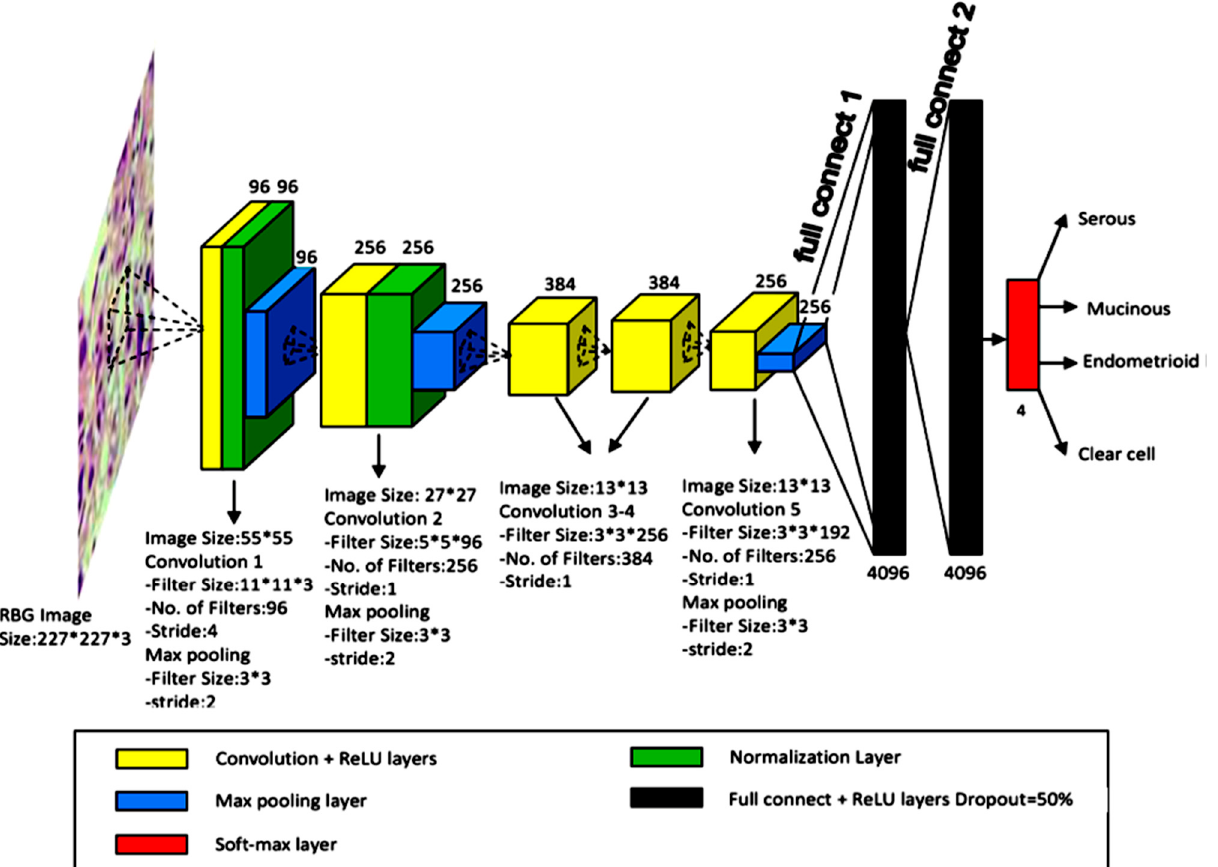
Figure 6. Example of cytological classification for ovarian cancer. The architecture and illustration of CNN for ovarian cancer image classification. (Source: Figure 4 in Wu et al. [29] . Reprinted with permission from the authors. Copyright (2019), Bioscience Reports, Portland Press [29] .)